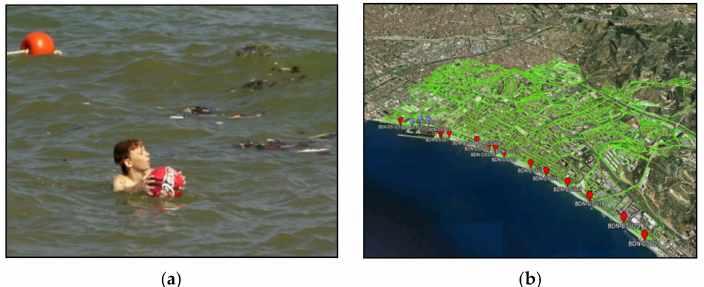
Figure 2. ( a ) Floating solids in Badalona bathing waters after a CSO; ( b ) Locations of sewer network CSO